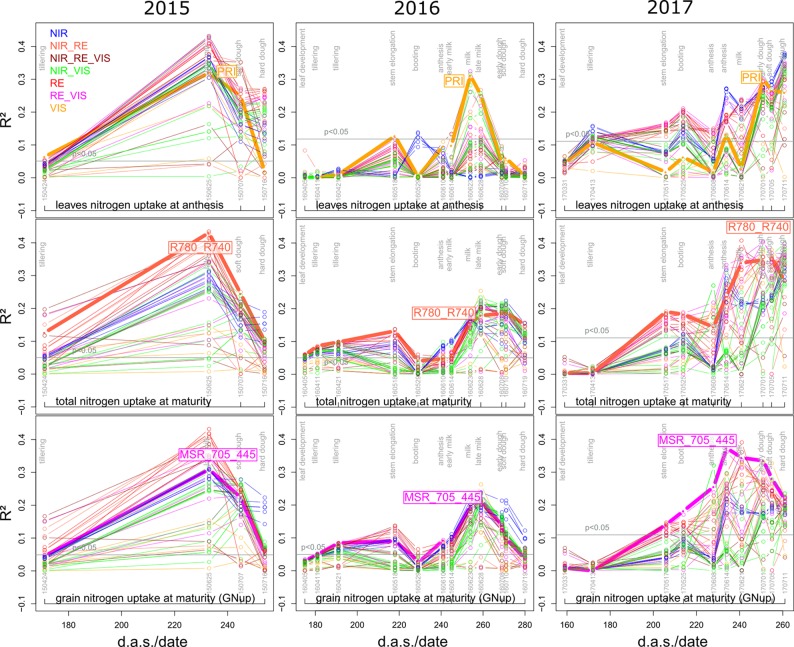
Seasonal coefficients of determination (R²) for selected N uptake (Nup) traits. See the legend of Figure 3 for details.